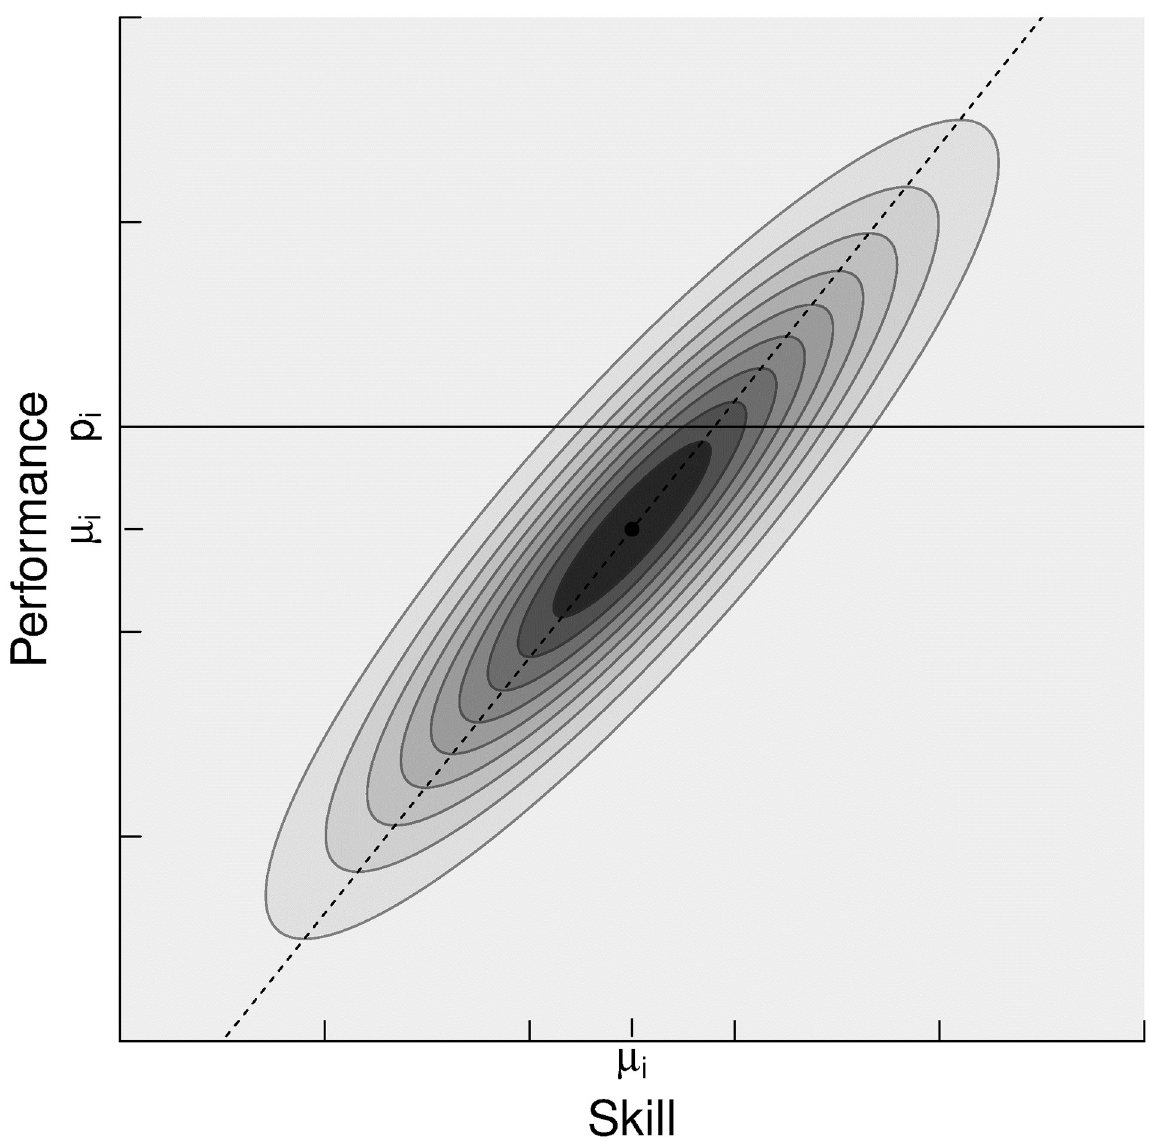
; μ ; σ 2 Þ . The area under the i i i